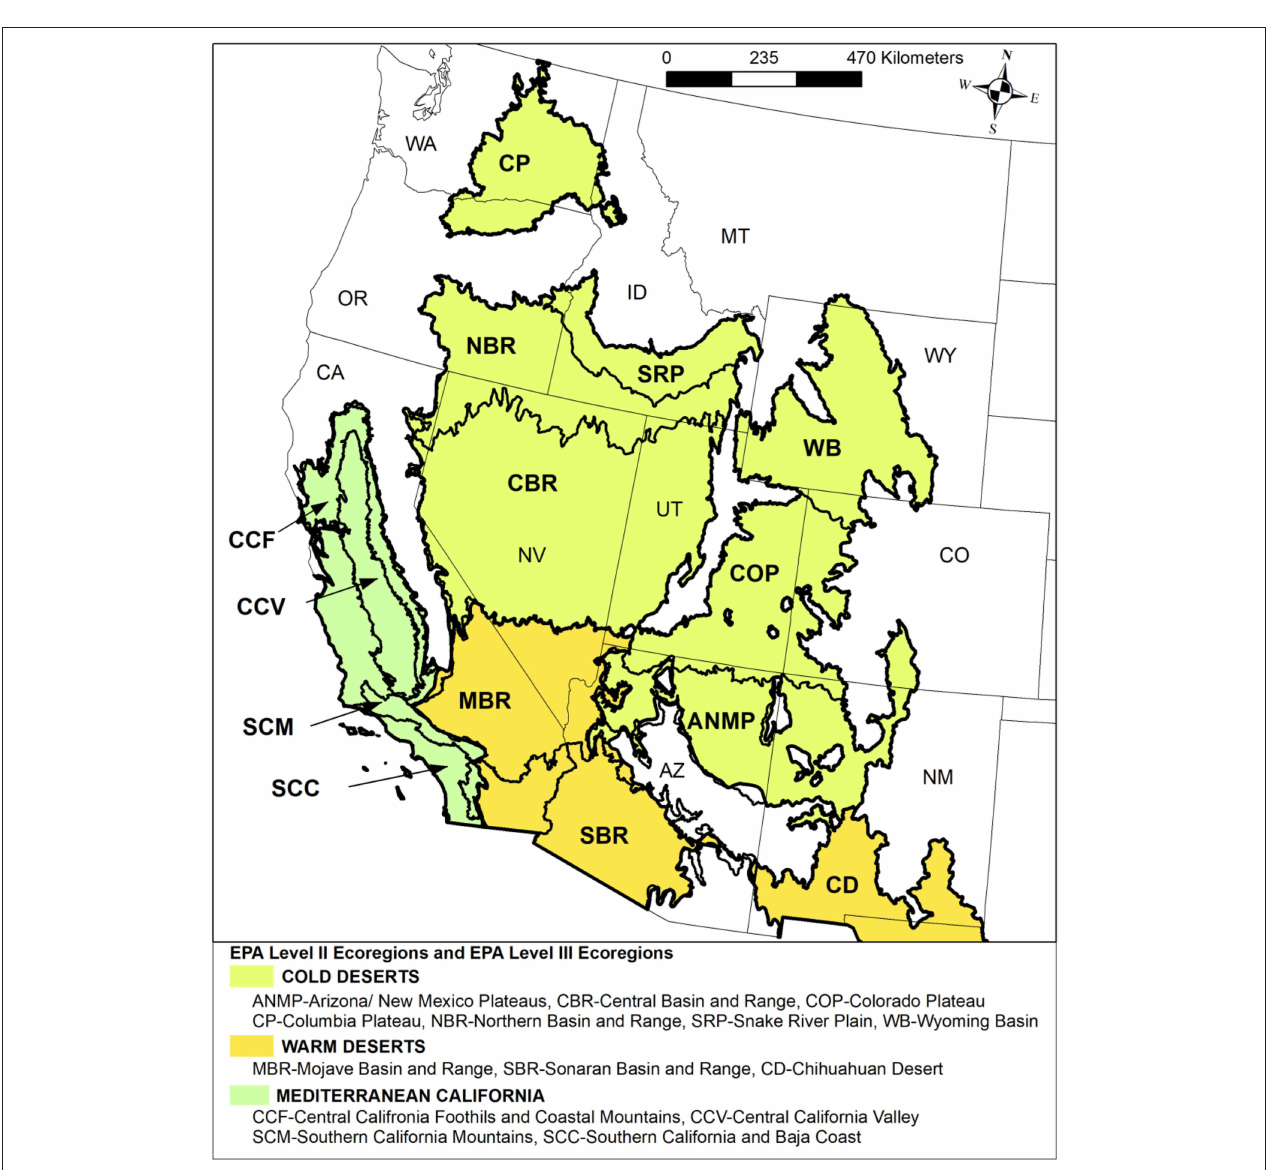
FIGURE 4 | A map of the Cold Deserts, Mediterranean Ecoregion, and Warm Deserts Level II Ecoregions in North America and the Level III Ecoregions within them (U.S. Environmental Protection Agency [USEPA].,